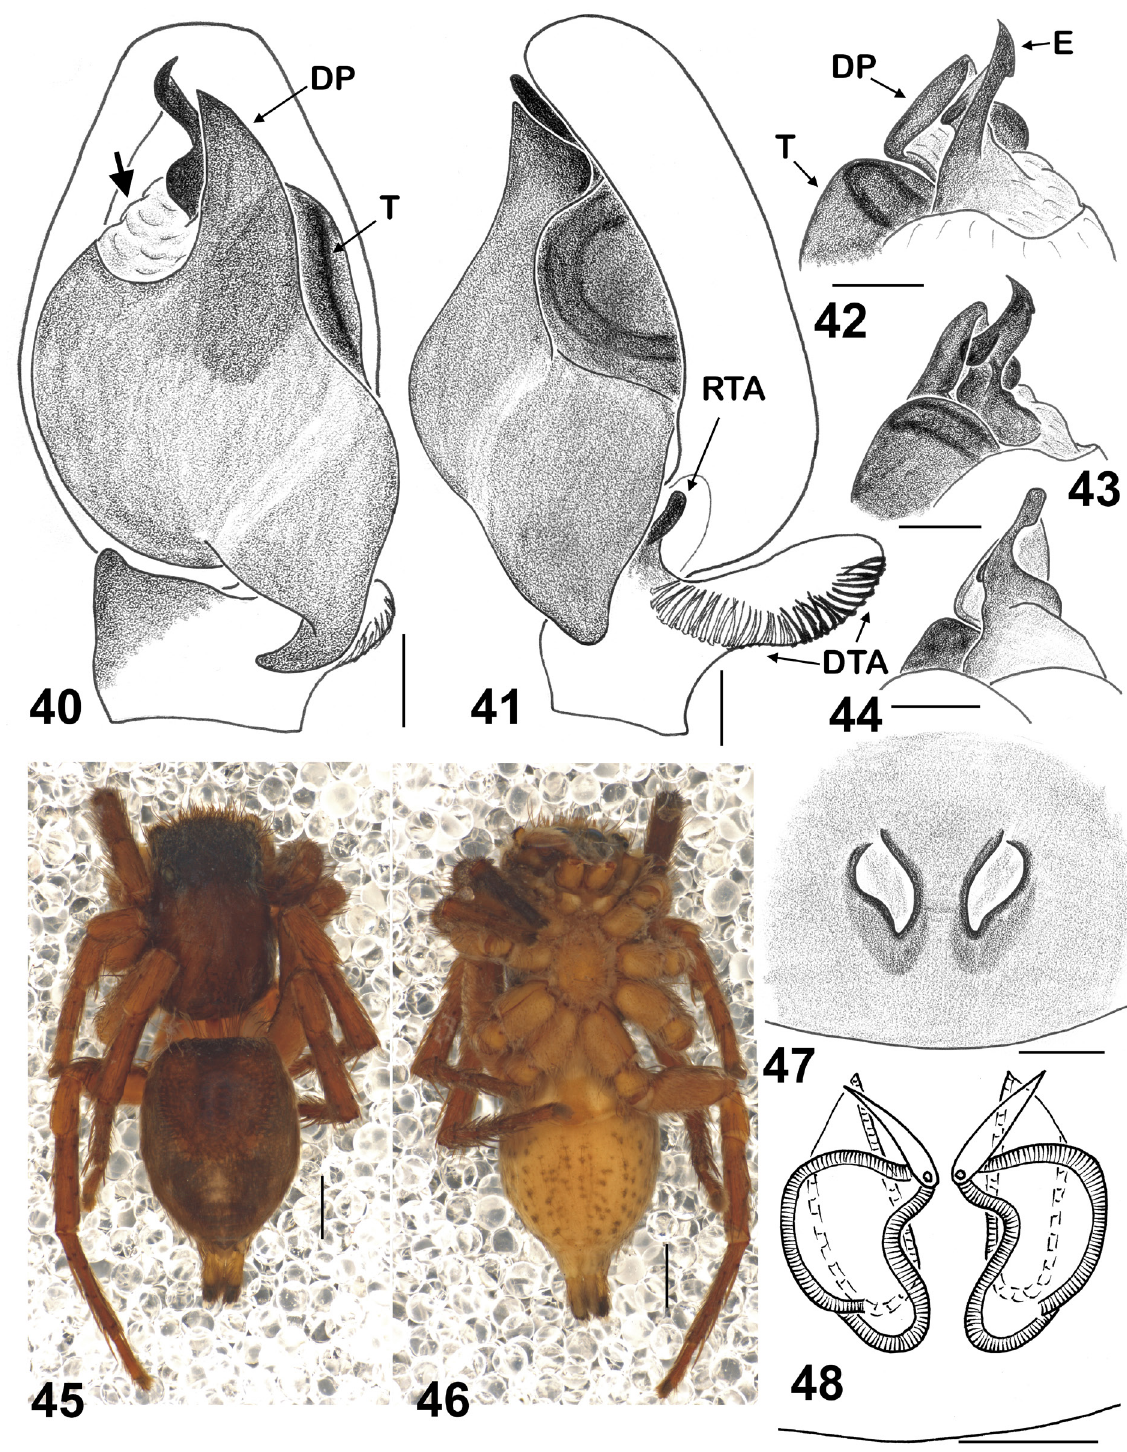
Figs 40–48. Stenaelurillus albopunctatus Caporiacco, 1949, lectotype, ♂ and paralectotype, ♀ . 40 . Male palp, ventral view. 41 . Male palp, retrolateral view. 42 . Embolic division, dorsal view. 43 . Embolic division, retrolateral view. 44 . Embolic division, median view. 45 . ♂, dorsal view. 46 . ♂, ventral view. 47 . Epigyne, ventral view. 48 . Spermathecae, dorsal view. Abbreviations: see Material and methods. Scale bars: 40–44, 47–48 = 0.1 mm; 45–46 = 1